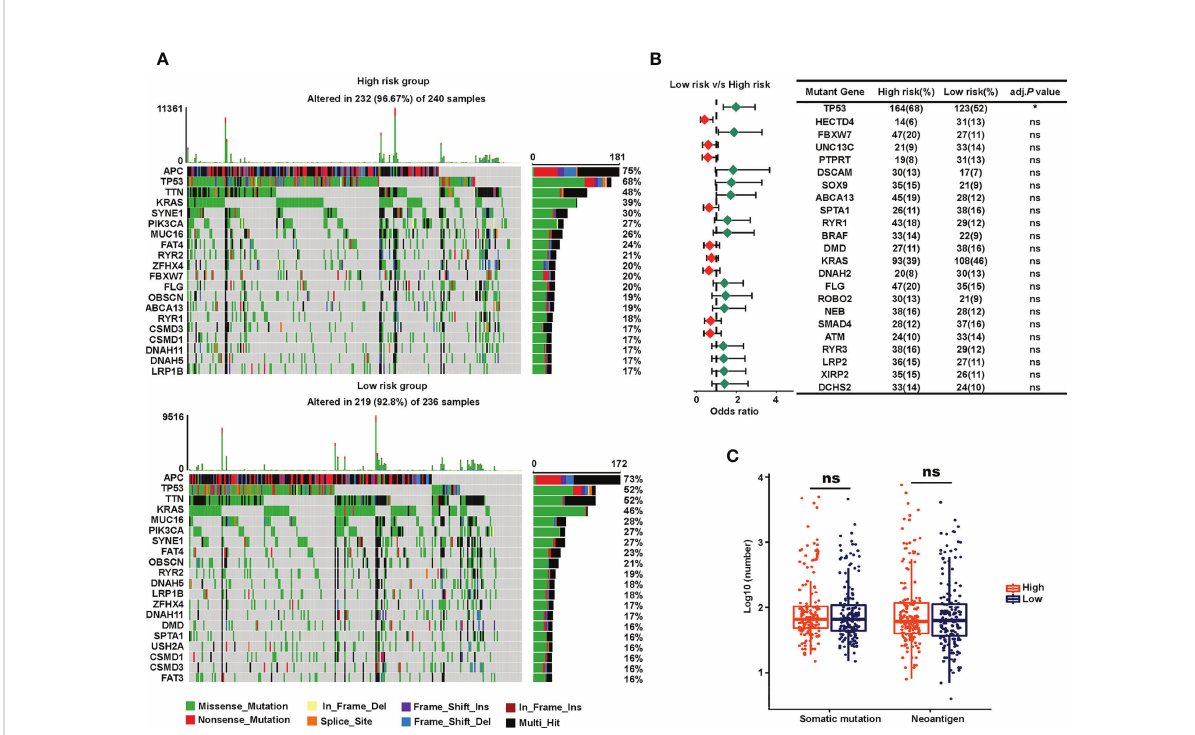
FIGURE 6 Somatic mutations of the high- and low-risk groups. (A) Waterfall of the top 20 tumor somatic mutations in the high-risk (up) and the low-risk (down) cohorts. (B) Forest plot showing the odds ratios of the 20 most signi fi cantly differentially distributed mutated genes between the two risk groups. (C) Numbers of somatic mutations and neoantigens in the high- and low-risk TCGA groups. * P< 0.05; ns, not signi fi